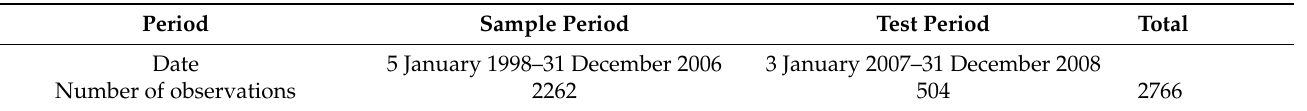
Table 6. Sample and test